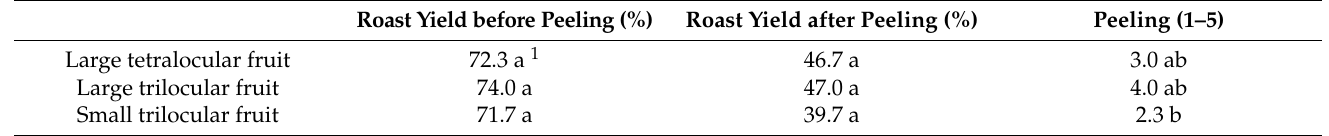
Table 3. Effect of morphological characteristics of the fruit on roast yield and peeling of roasted pepper.